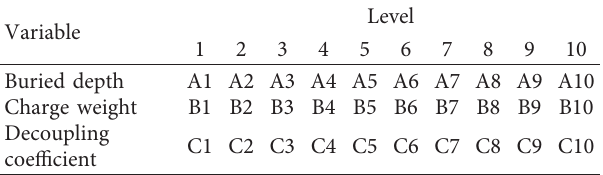
Table 1: Orthogonal design of 10-level variables. Variable